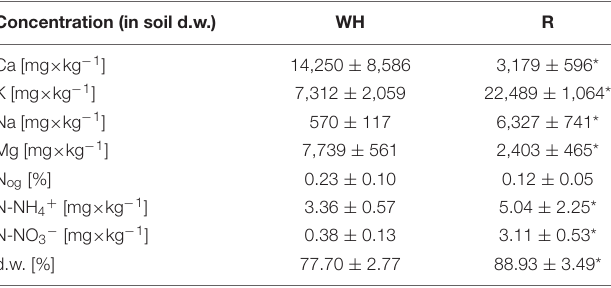
TABLE 5 | Macroelements concentration in the metal-polluted waste heap (WH) and non-polluted reference (R) soils. Concentration (in soil